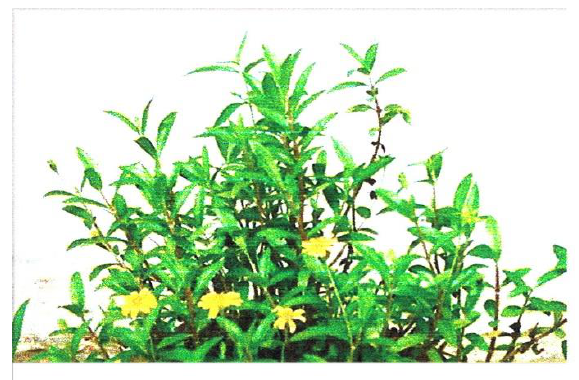
Figure 5. A photograph of the plant Wedelia